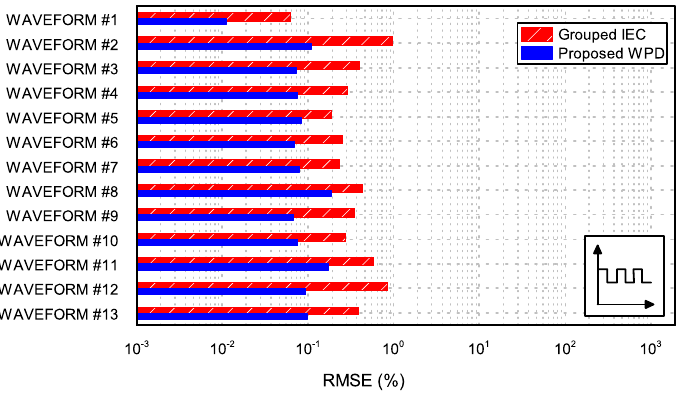
Figure 9. RMSE for each assessed waveform under fluctuating conditions, for grouped IEC and WPD, in the case of flicker-type rectangular